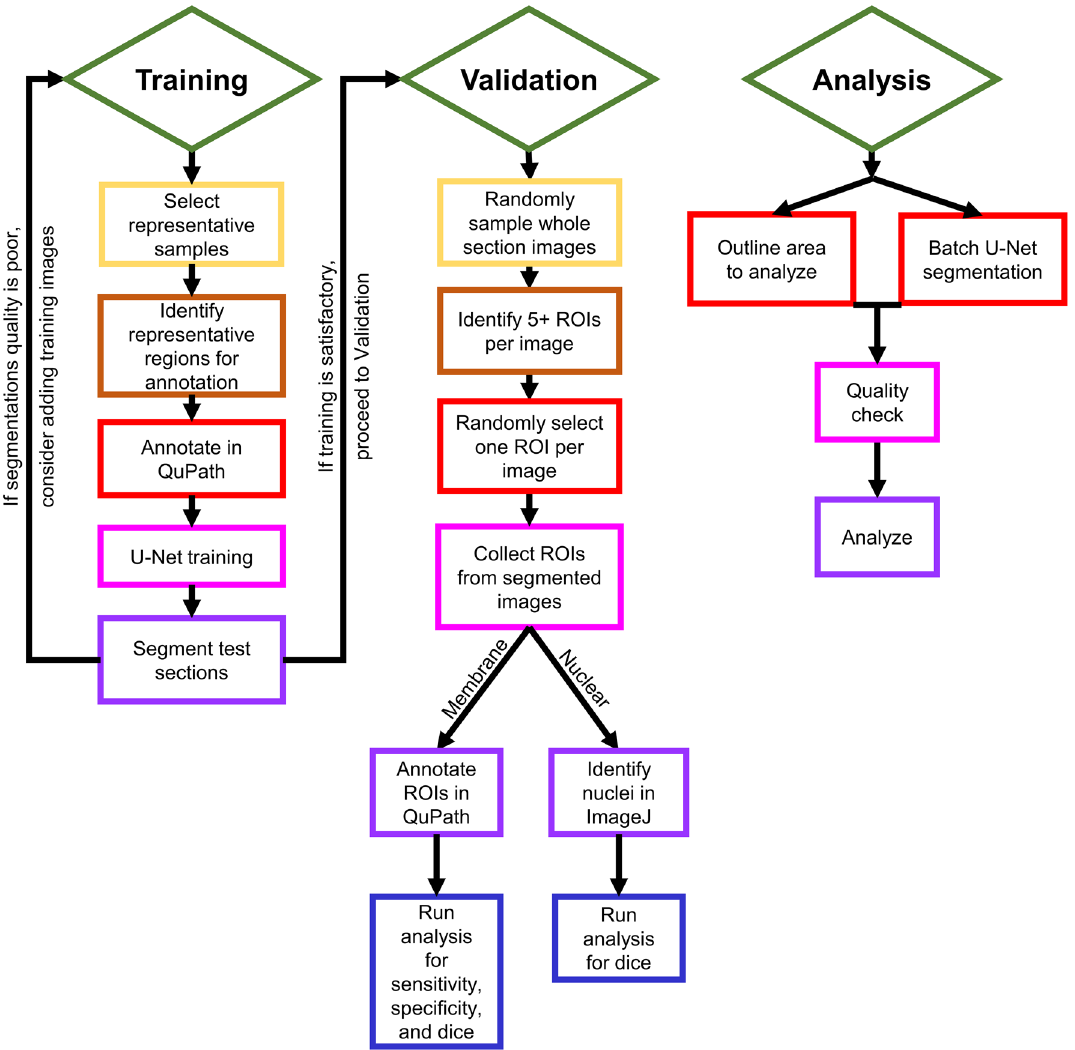
Figure 1. Flowchart of processing steps in each domain. Processing was divided into three domains: training, validation, and analysis. Each domain requires a library of whole-section, single-channel images as input. Detailed instructions for completing each flowchart task, including example data and example models, is available at https:// github. com/ Beami sh- Lab/ High- throu ghput- Image- Analy sis- of- Kidney-